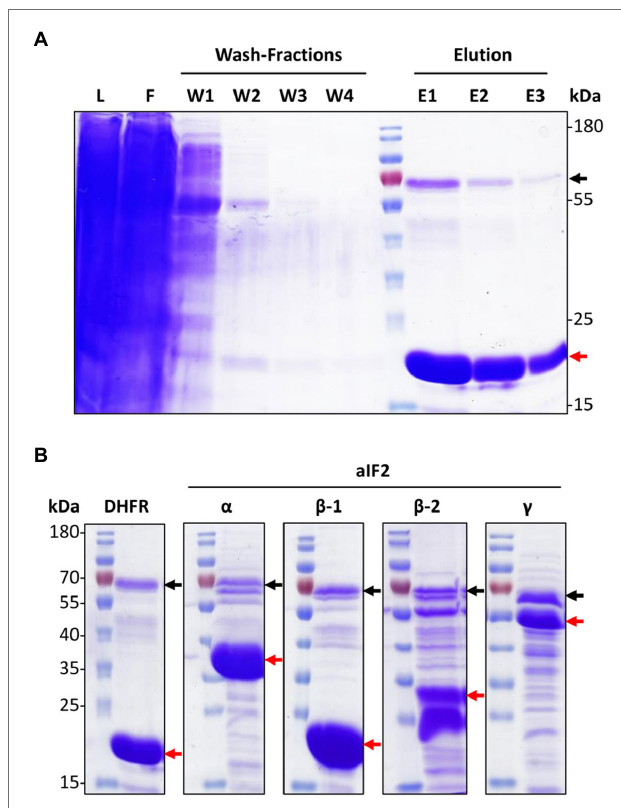
FIGURE 1 | Overproduction and co-affinity purification of N-His 6 -tagged proteins. (A) SDS-Page representing different steps of the co-affinity purification of the negative control protein N-His 6 DHFR. The red arrow points to N-His 6 DHFR, the black arrow to an endogenous histidine-rich protein of H. volcanii , PitA. L – lysate, F – flow through, W – washing fractions, E – elution fractions. (B) SDS-Page of the elution fraction 1 from the co- affinity purifications of N-His 6 -tagged DHFR and the four indicated aIF2 subunits. Black and red arrows point to PitA and the produced His 6 -tagged respective aIF2 subunits. The figure shows one typical example of three biological replicates for each